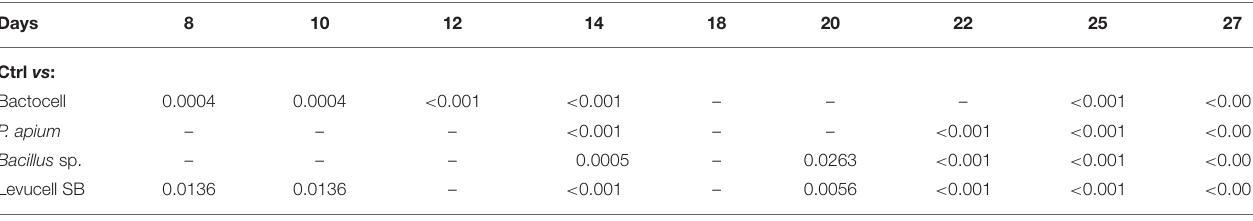
TABLE 5 | Cox Proportional Hazard model (Cox-model) comparisons between survival of the control group (ctrl) and probiotic controls groups during the 27 days experiment. Days